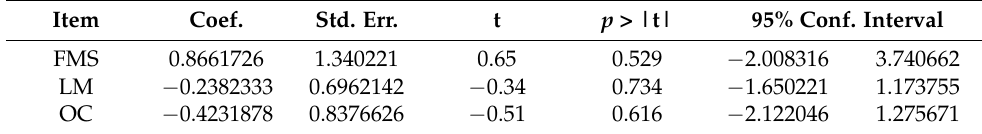
Table 2. The result of publication bias estimation.